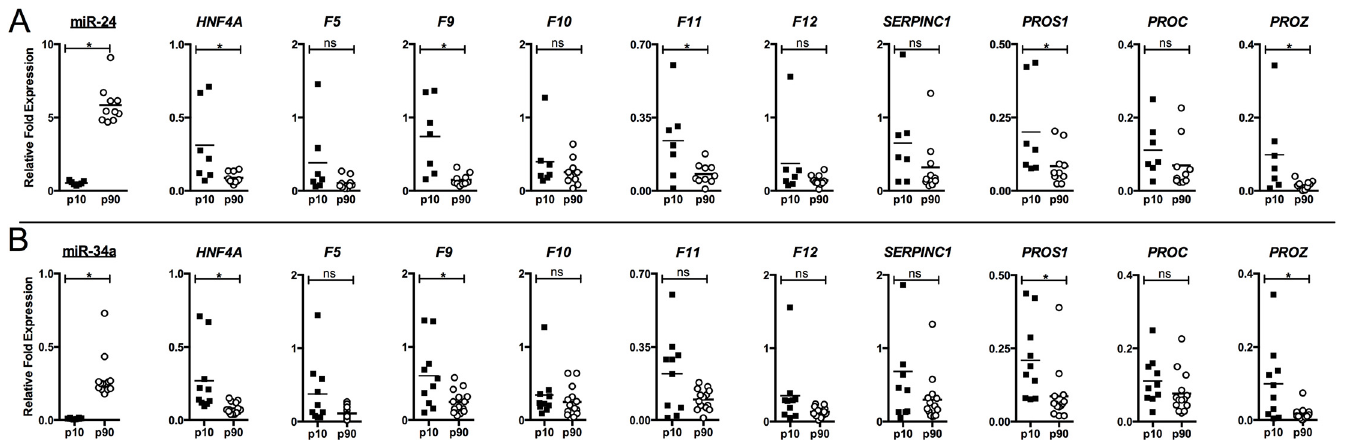
Fig 6. Expression range of miR-24 and miR-34a with HNF4A mRNA and its downstream targets in healthy livers. Dot plot diagram of HNF4A mRNA, selected coagulation factors and miR-24 (A) or miR-34a (B) levels in livers. P10 and p90 represent 10 th and 90 th percentiles of miR-24 (A) and miR-34a (B), respectively. Each data point represents an individual liver tissue sample. The results are presented as fold change with respect to the normalization standard. The asterisk indicates a statistically significant difference (P < 0.05) and “ ns ” indicates a statistically non-significant difference (P > 0.05).